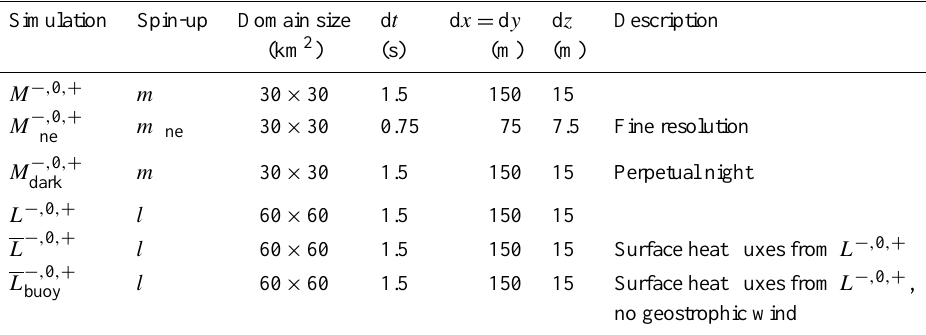
Table 2. List of simulations. The superscripts − , 0, and + denote low, reference, and high geostrophic wind speed, respectively (see Sect. 2.2). All three superscripts are used when referring to all three simulations in a set. Simulations that use prescribed, spatially homogenized surface sensible heat and moisture fluxes carry an